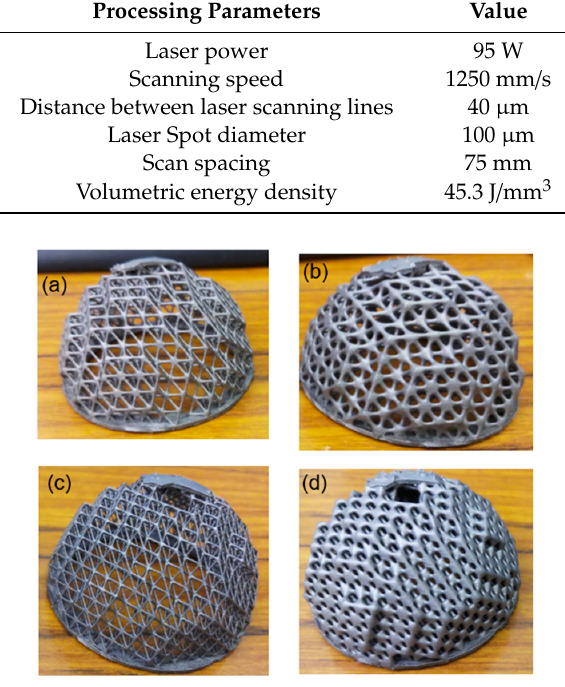
Figure 7. Some of the cellular implants (AC) with vintiles structures built by the SLM process. ( a ) Non-optimized with 5 × 5 × 5 mm unit size, ( b ) optimized with 6 × 6 × 6 mm unit size, ( c ) non- optimized with 5 × 5 × 5 mm unit size, and ( d ) optimized with 5 × 5 × 5 mm unit